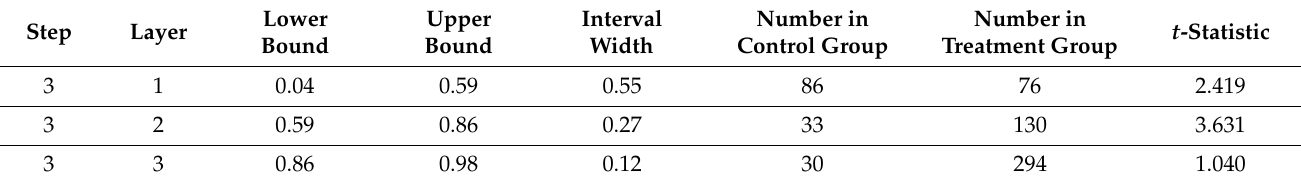
Table 6. The results of the second stratification.